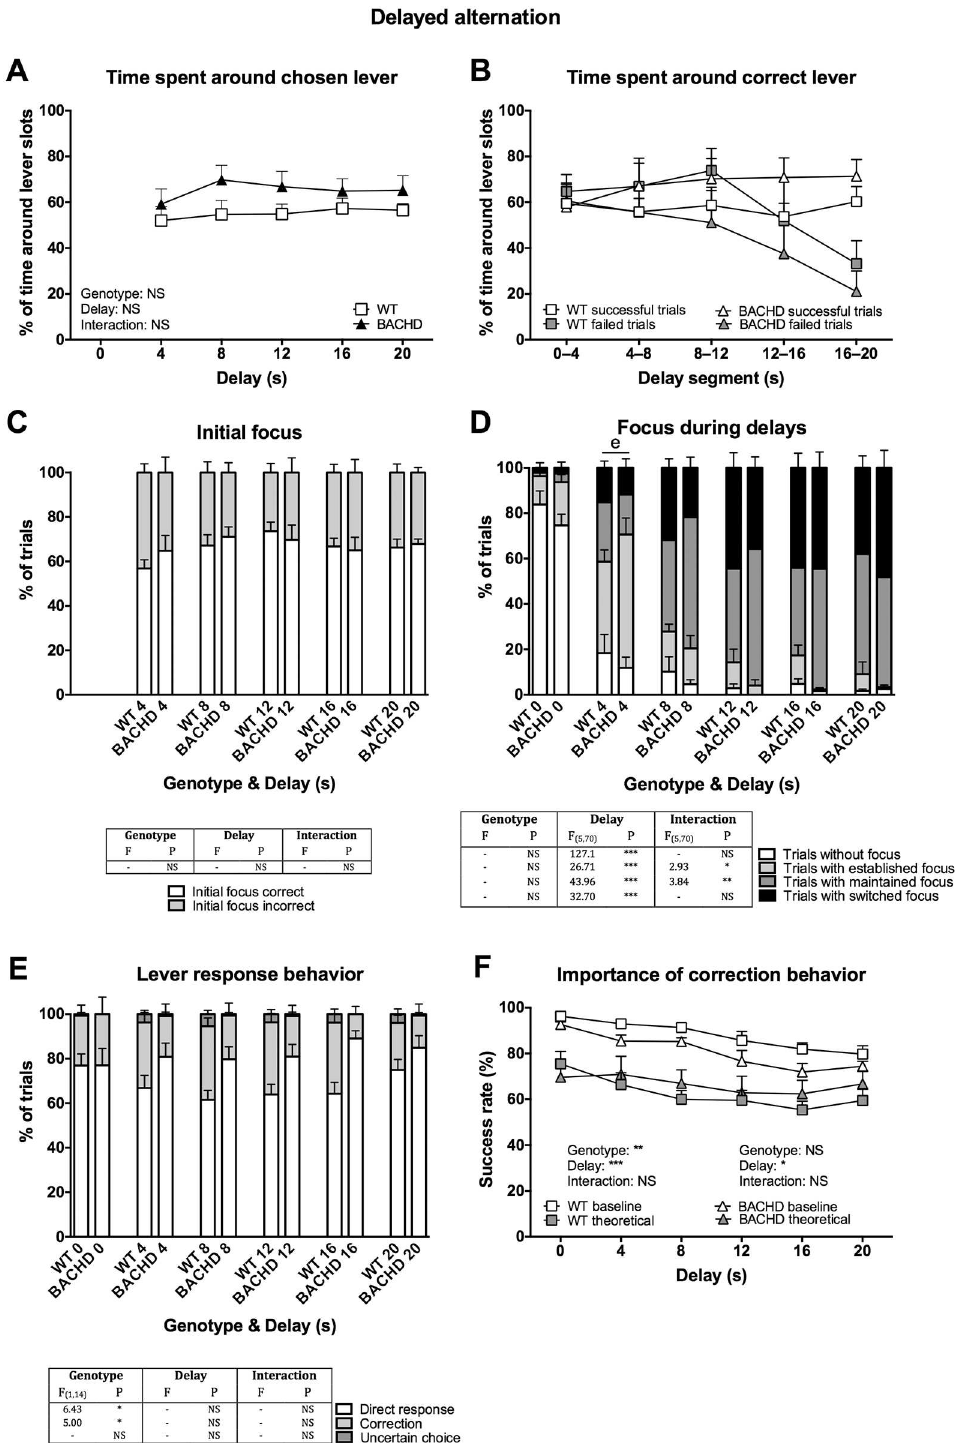
Fig 10. Video-scored behavior in relation to performanceon delayed alternation. The graphsshow variousaspects of the behaviors scored from video recordings in relationto the rats’ performance in the delayed alternationtest. Graphs indicategroup mean plus standarderror. (B) concernsthe 20-second delay step. In (F), the data that is labeled"theoretical" displaysthe theoreticalsuccess rates, as if the rats had responded accordingto their initial lever interest and not performed a correction behavior.Further